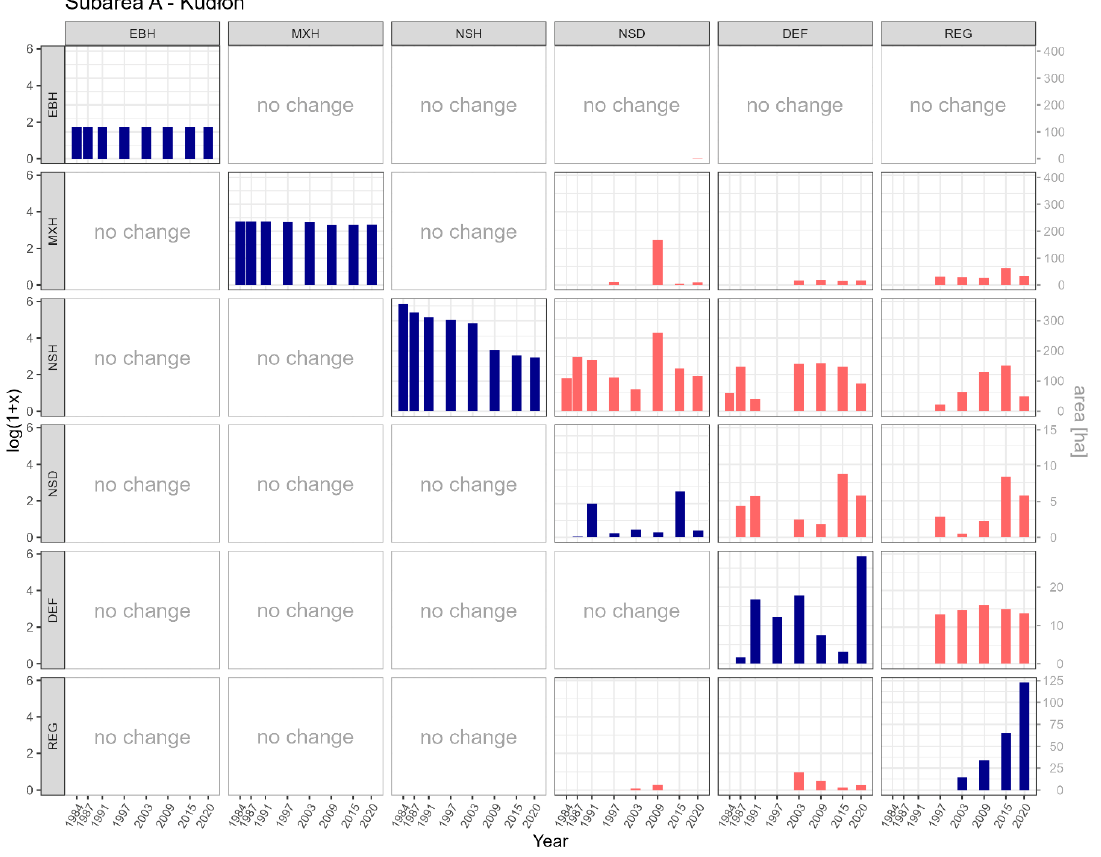
Figure 3. LC classes conversion matrix in subarea A (the Kudłoń range) for analyzed time periods. Data represented with red bars was logarithmically transformed (left y axis), changes represented with blue bars are shown in hectares (right y axis).